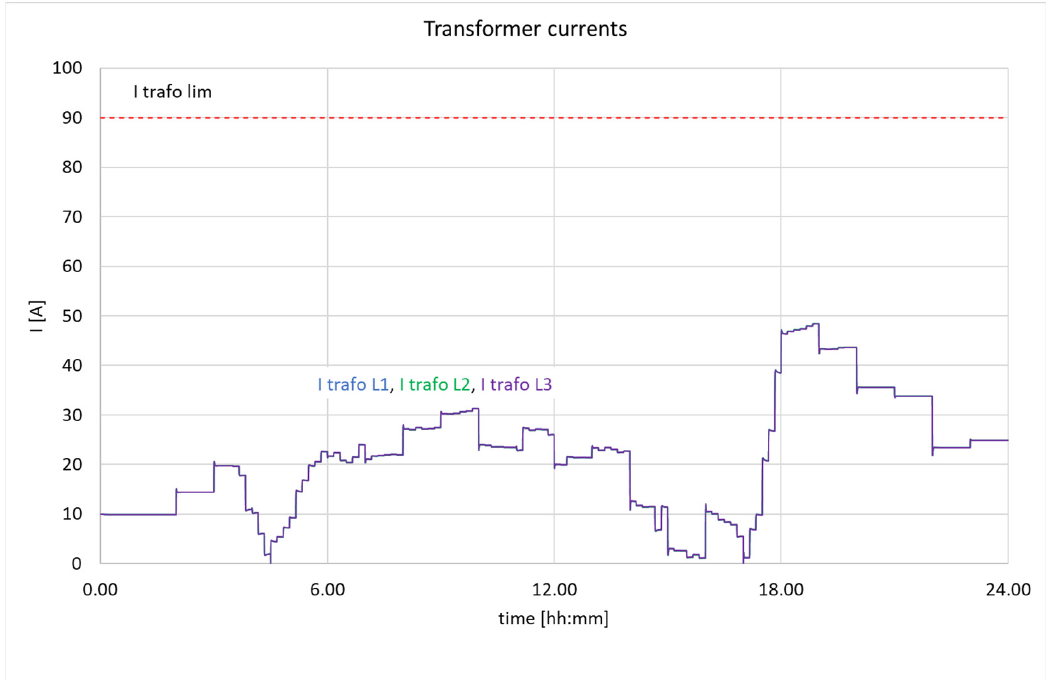
Figure 10. MV/LV transformer currents during one-day simulation, the case of 3-phase PV inverters in prosumer installations with implemented control algorithm.